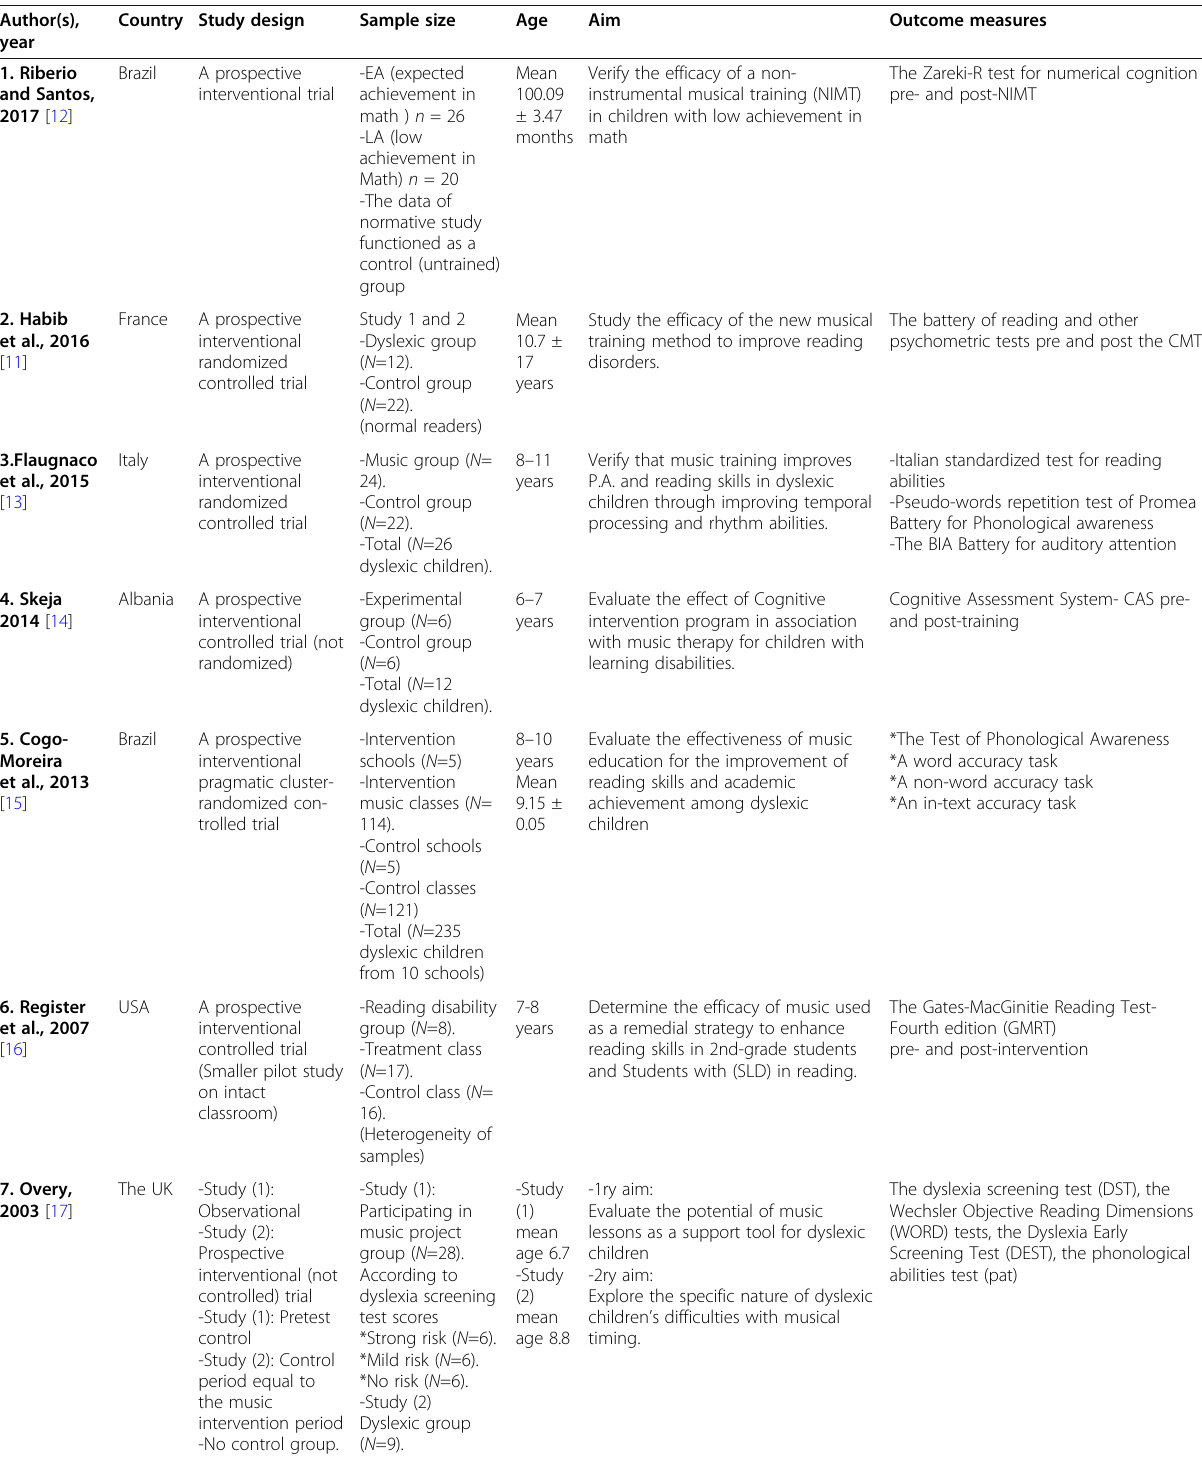
Table 1 Summary of authors ’ names, year of publication, study design, sample size, age of participants, aim, and outcome measures of included